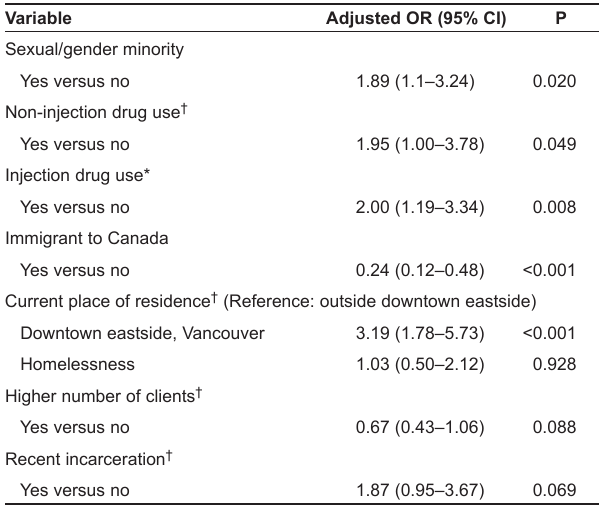
Table 2 Multivariable logistic regression model of factors associated with recent hepatitis C virus (HCV) testing among self- reported HCV-negative female sex workers in